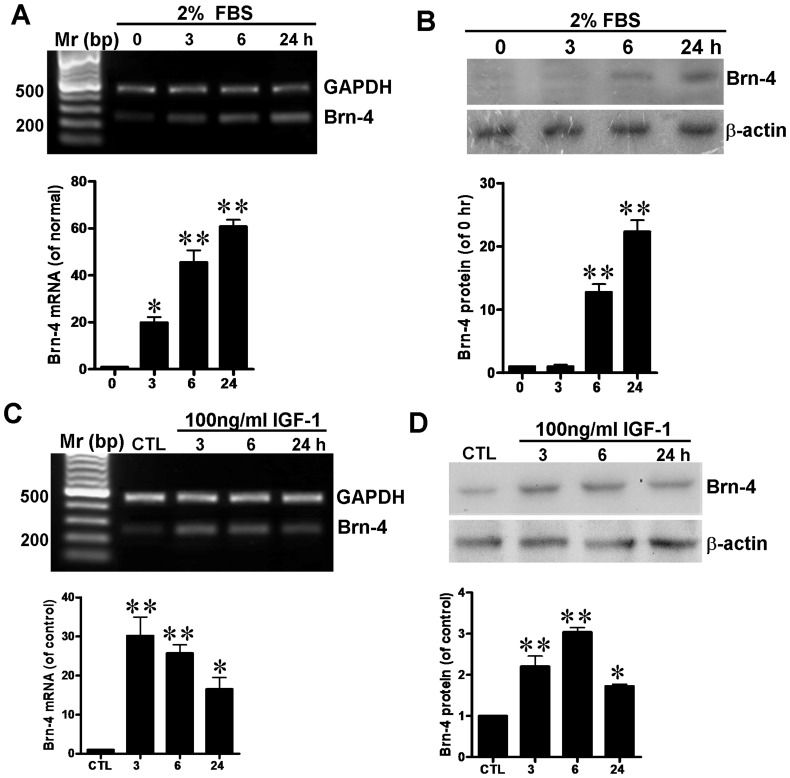
Brn-4 expression in hippocampus-derived NSCs cultured in differentiation medium with (C, D) or without (A, B) IGF-2.(A) Brn-4 mRNA levels in hippocampal NSCs determined by RT-PCR at different time-points (0, 3, 6, and 24 h) following transfer to differentiation medium (DMEM, 2% FBS). GAPDH was used as the reference. Lower panel is quantification of Brn-4 mRNA. (B) Brn-4 protein (39 kDa) levels detected by western blotting different time-points (0, 3, 6, and 24 h) following transfer to differentiation medium; β-actin (42 kDa) provided the reference. Lower panel is quantification of Brn-4 protein. Data are means ± s.e.m.; *, P<0.05; **, P<0.01 versus 0 h. (C, D) Effect of IGF-1 on Brn-4 mRNA and protein expression in hippocampal NSCs in vitro. Hippocampal NSCs were incubated in differentiation medium containing IGF-1 (100 ng/ml) for 3, 6 or 24 h; control cells were incubated in differentiation medium alone for 24 h. Brn-4 mRNA and protein were determined by RT-PCR (C) and western blotting (D) analysis, demonstrating upregulation of Brn-4 after IGF-1 treatment in time-course manner. Data are means ± s.e.m.; *, P<0.05; **, P<0.01 versus control (CTL).